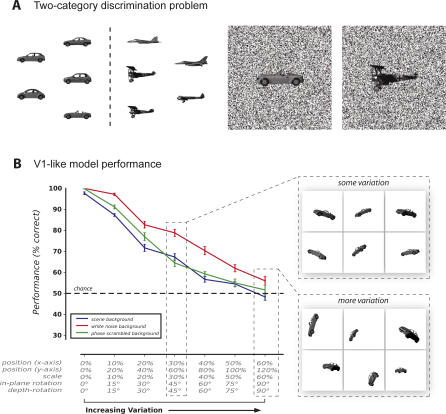
The Same Simple V1-Like Model That Performed Well in Figure 1 Is Not a Good Model of Object Recognition—It Fails Badly on a “Simple” Problem That Explicitly Requires Tolerance to Image Variation(A) We used 3-D models of cars and planes to generate image sets for performing a cars-versus-planes two-category test. By using 3-D models, we were able to parametrically control the amount of identity-preserving variation that the system was required to tolerate to perform the task (i.e., variation in each object's position, scale, pose). The 3-D models were rendered using ray-tracing software (see Methods), and were placed on either a white noise background (shown here), a scene background, or a phase scrambled background (these backgrounds are themselves another form of variation that a recognition system must tolerate; see Figure S1).(B) As the amount of variation was increased (x-axis), performance drops off, eventually reaching chance level (50%). Here, we used 100 training and 30 testing images for each object category. However, using substantially more exemplar images (1,530 training, 1,530 testing) yielded only mild performance gains (e.g., 2.7% for the fourth variation level using white noise background), indicating that the failure of this model is not due to under-training. Error bars represent the standard error of the mean computed over ten random splits of training and testing images (see Methods). This result highlights a fundamental problem in the current use of “natural” images to test object recognition models. By the logic of the “natural” Caltech101 test set, this task should be easy, because it has just two object categories, while the Caltech101 test should be hard (102 object categories). However, this V1-like model fails badly with this “easy” set, in spite of high performance on the Caltech101 test set (Figure 1).